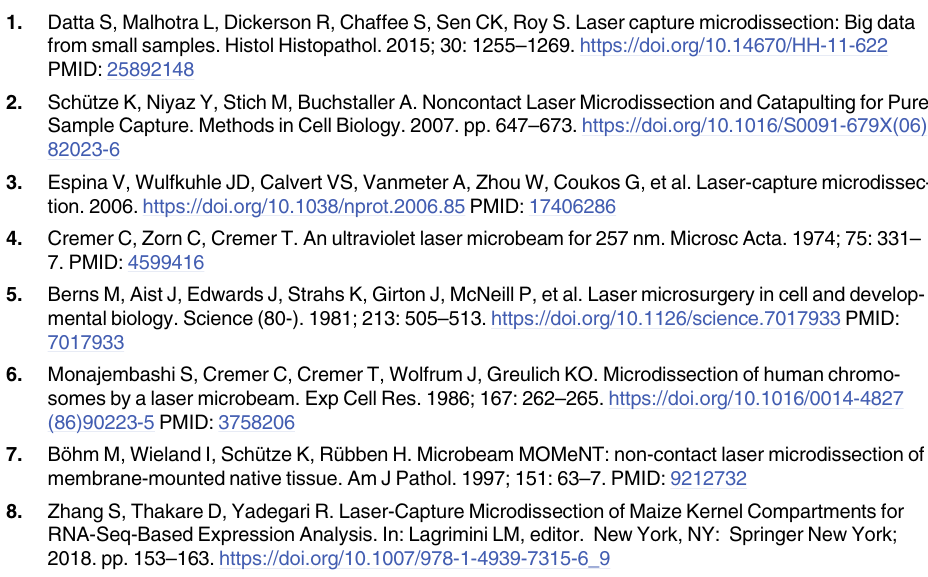
S2 Table. Unique tissue-specific peptidases and peptidase